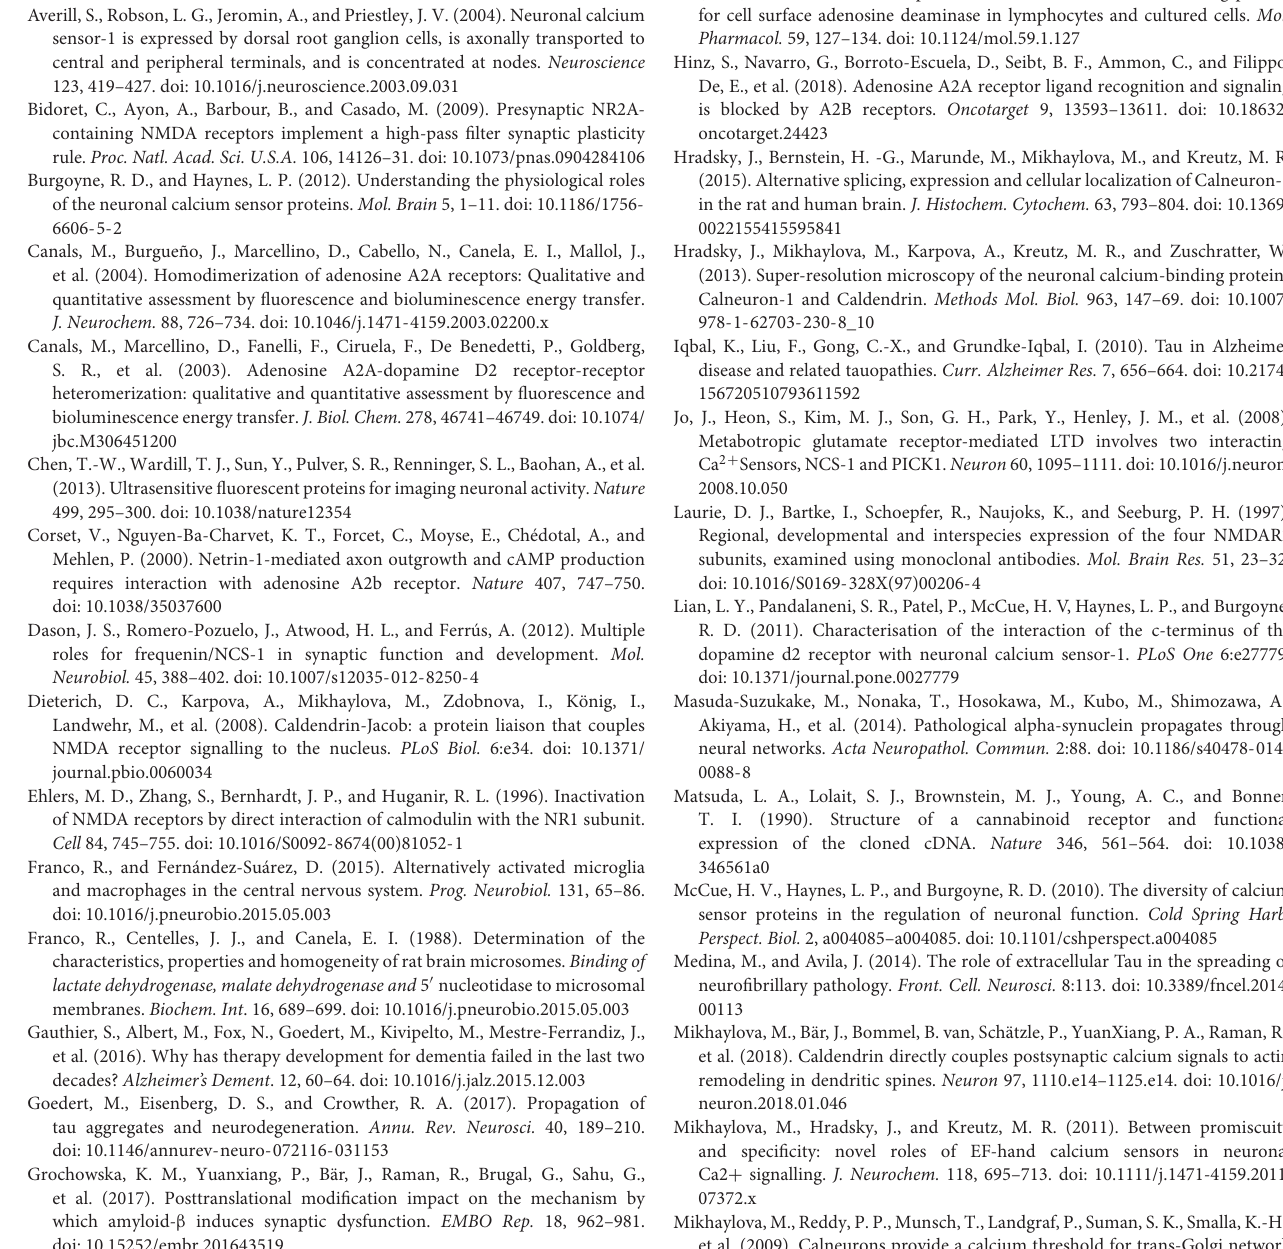
FIGURE S4 | Chronic treatment with Tau, p-Tau, or α -synuclein inhibits NMDAR-mediated signaling in primary cultures. (A–D) MAPK phosphorylation levels were analyzed after stimulating primary cultures of cortical (A) , or hippocampal neurons (B) , or of cortex (C) , or hippocampal microglia (D) . Experiments were performed in cells transfected or not (black bars) with siRNA to silence calneuron-1 (red bars), CaM (green bars), or NCS1 (blue bars) expression. Assays were performed in cells treated with α -synuclein, Tau or p-Tau for 7 days prior to 15 µ M NMDA addition. Labels in X axis are equal in all bar graphs. Values are the mean ± SEM ( n = 10). Significant differences over non-treated cells ( ∗∗ p < 0.01, ∗∗∗ p < 0.005) or over NMDA treatment ( & p < 0.05, && p < 0.01, and &&& p < 0.001) were calculated by one-way ANOVA and Bonferroni post hoc test.